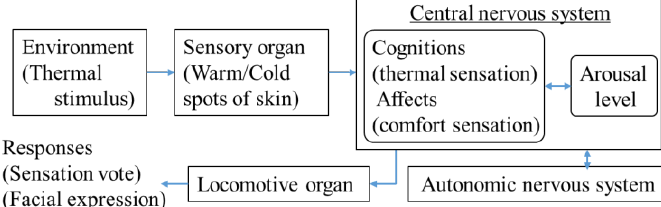
Figure 1. Flow of physiological responses with the thermal stimulus.